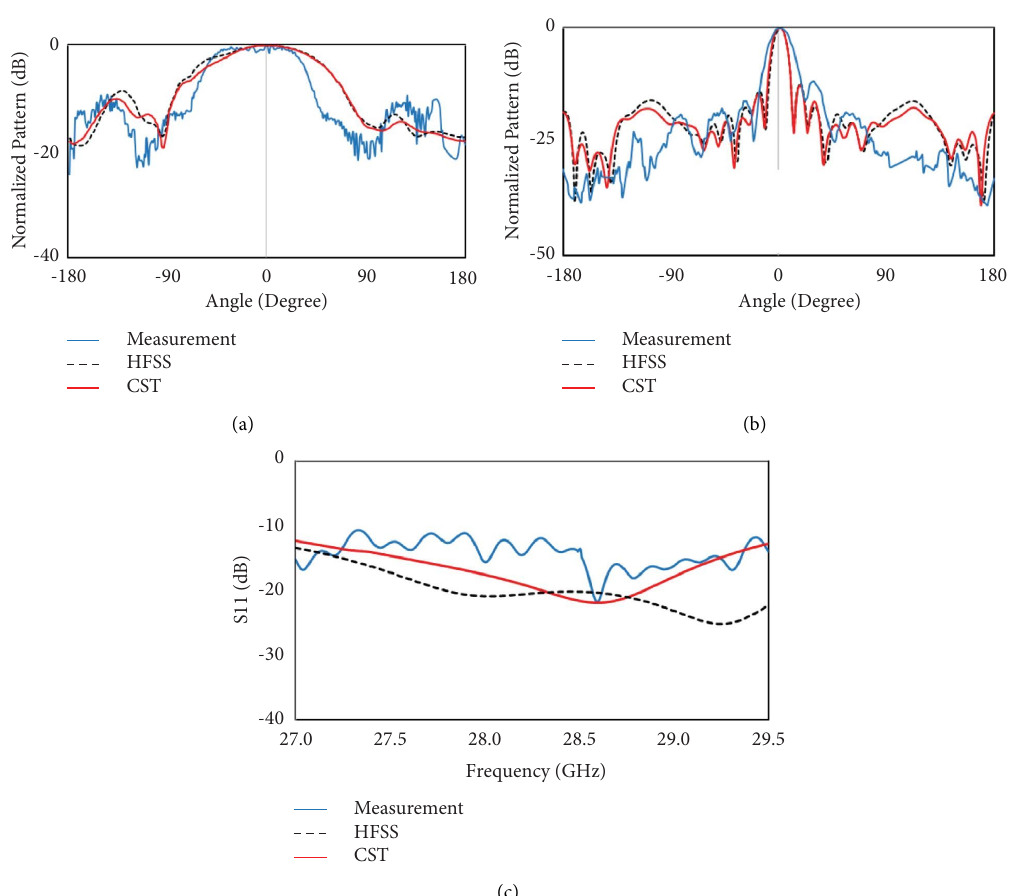
11 coefcient of the proposed antennas at 28GHz;